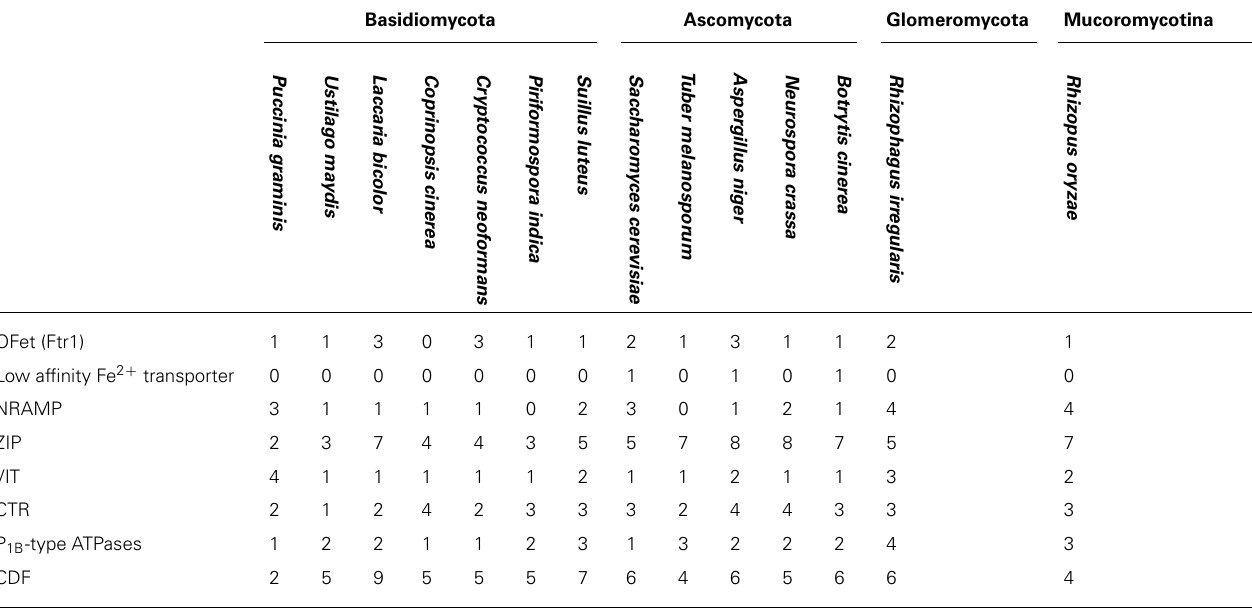
Table 2 | Number and classification of the putative Cu, Fe, and Zn transporters identified in the genome of R. irregularis and in the genomes of the reference fungi used in this